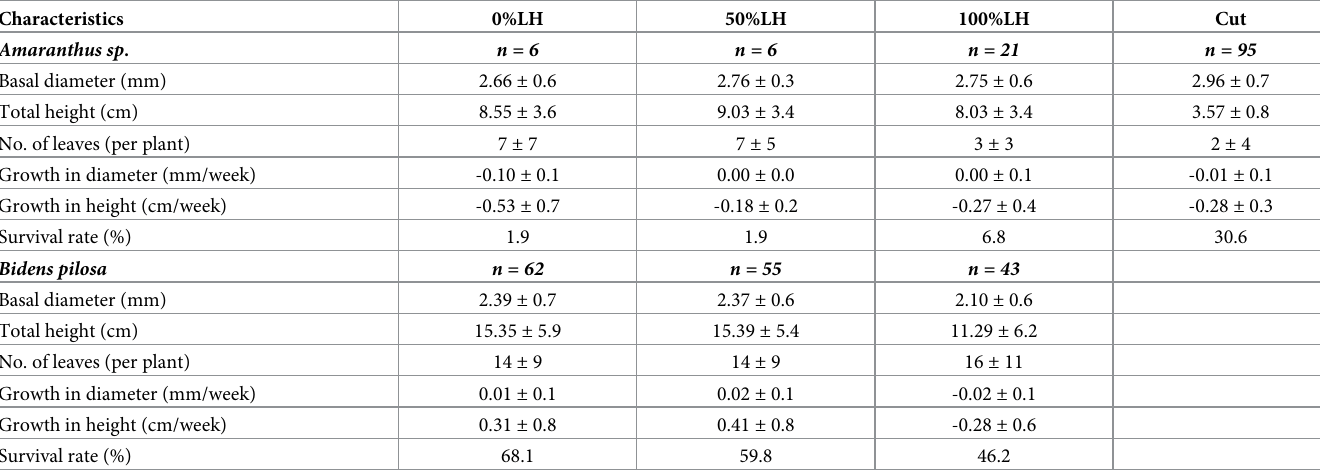
Table 6. Mean values of the considered characteristics ( ± SD) of the study species between harvesting treatments, after second harvest. Characteristics Cut Amaranthus sp .